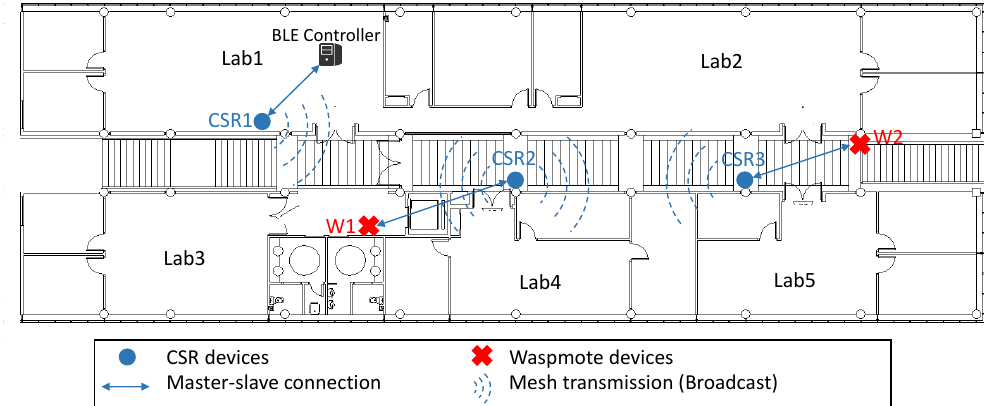
Figure 11. Network deployed using 2 sensor devices and CSR mesh topology.